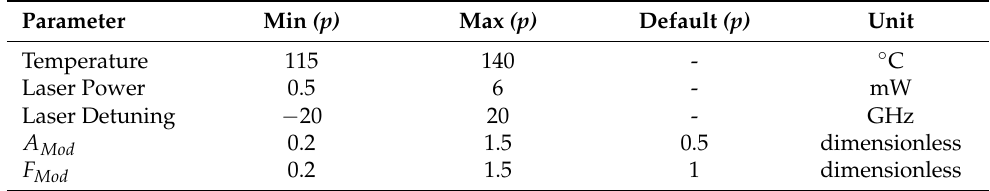
Table 1. Definition of all controlled parameters ( p ) used for optimisation, with corresponding units. Min ( p ), the minimum value for each parameter. Max ( p ), the maximum value for each parameter. Default ( p ), chosen default value if parameter is not directly optimised during